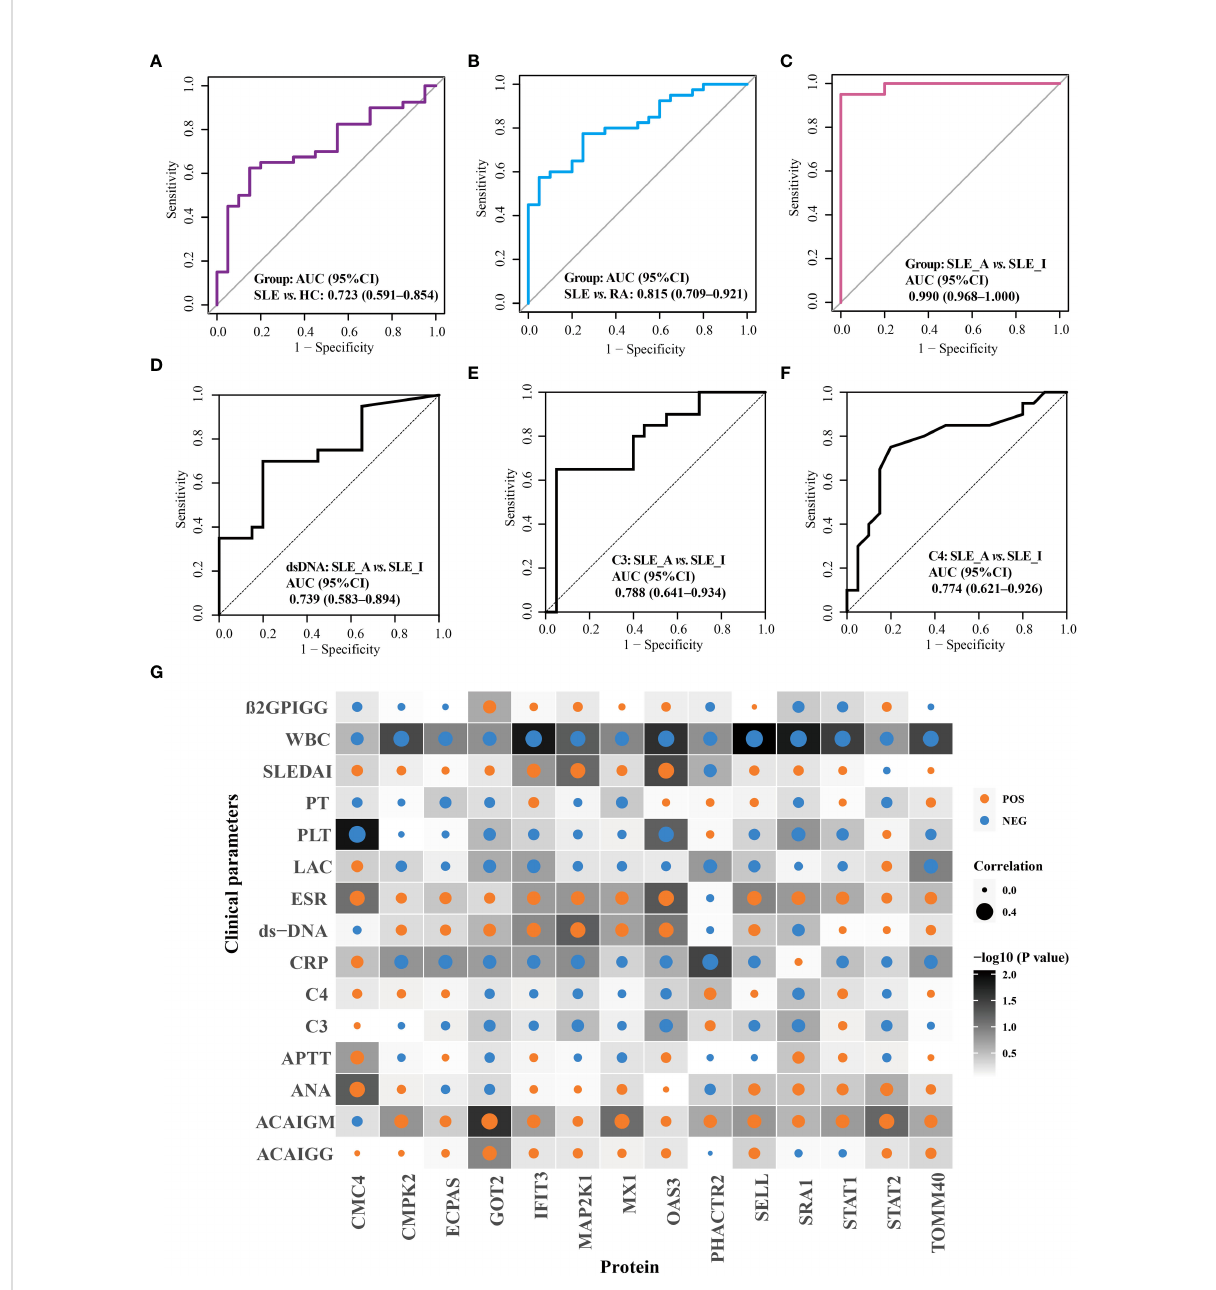
FIGURE 5 Validation of disease diagnosis and assessing disease exacerbation biomarker combinations of SLE patients. ROC curves for the disease diagnosis of distinguishing SLE from HC (A) and SLE from RA (B) . ROC curve for the assessing disease exacerbation of distinguishing SLE_A from SLE_I (C) . ROC curves for distinguishing SLE_A from SLE_I using anti-DNA (D) , C3 (E) , and C4 (F) . (G) Correlation plot of clinical parameters with biomarkers. Each square represents a correlation. A darker background indicates a lower P value, as determined by Spearman correlation. The size of the dot in each square represents the magnitude of the correlation, with a bigger dot representing higher correlation. Blue and orange dots indicate negative correlation and positive correlation,